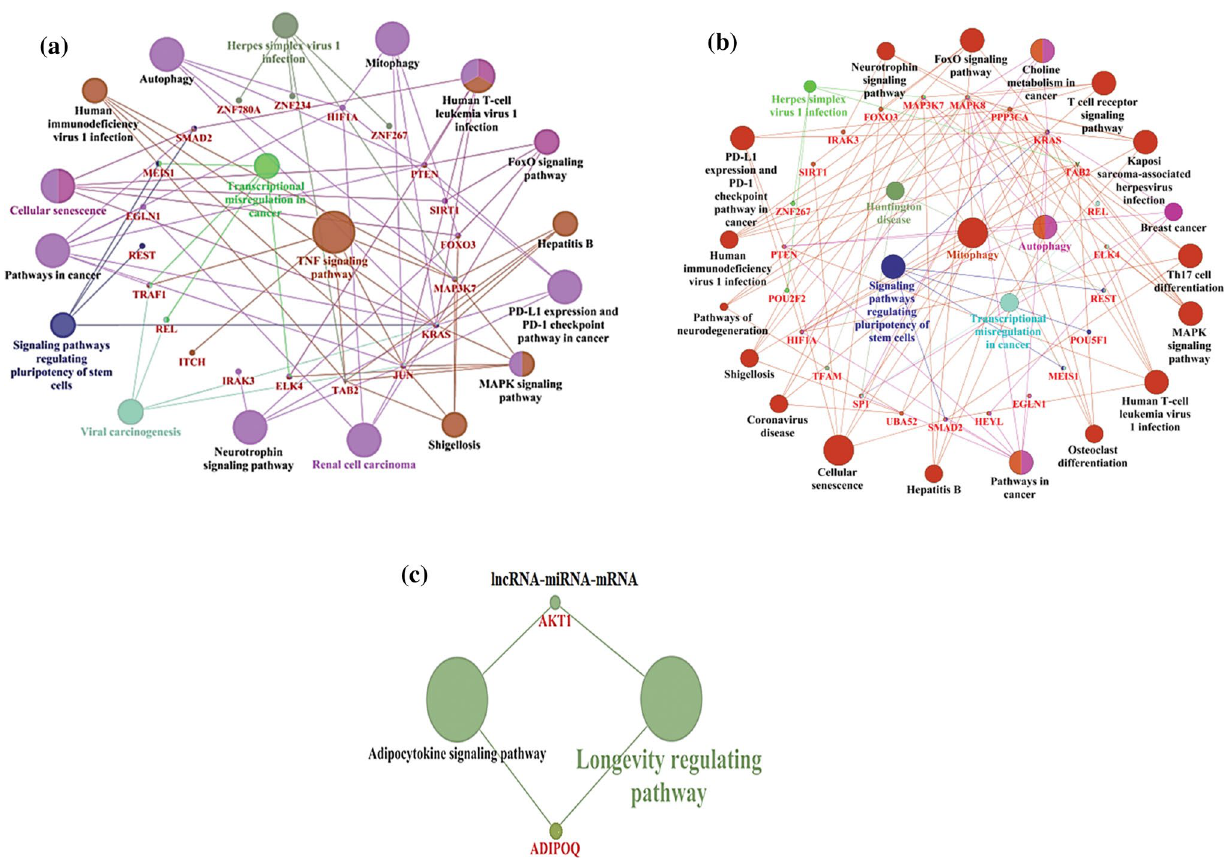
Fig. 5 a Cytoscape network of the lncRNA-miRNA axis regulating key mRNA genes in OS-P vs. OS cells. b Cytoscape network of lncRNA- miRNA regulating key mRNA genes in the OS-EP vs. OS-P set. c Cytoscape network of lncRNA-miRNA regulating key mRNA genes in OS-R vs. OS cells